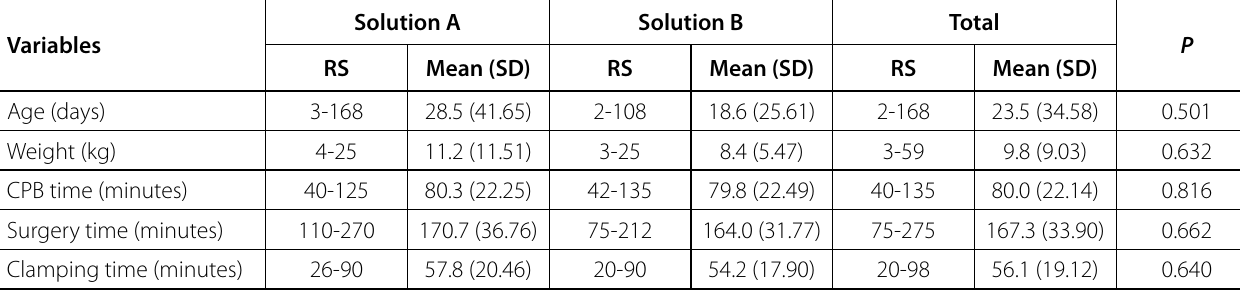
Table 3 . Distribution of numerical variables according to the groups. Variables